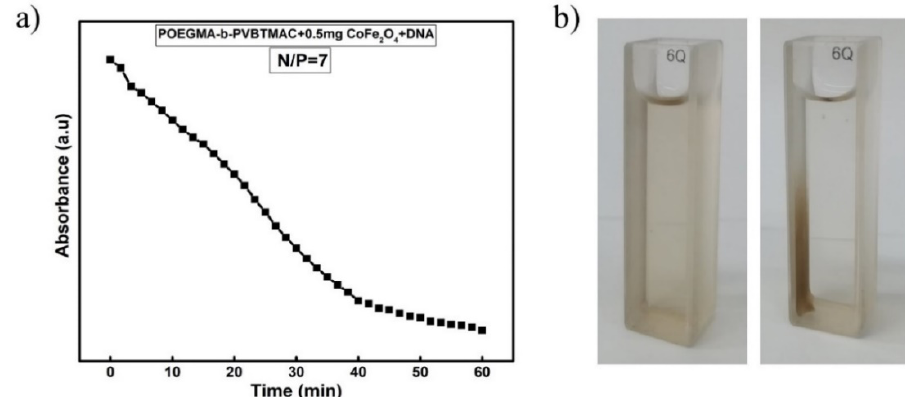
Figure 9. ( a ) Magnetophoresis plot showing absorbance as a function of time for magnetopolyplexes ( λ = 450 nm) at N / P = 7, ( b ) magnetopolyplexes before and after the application of magnetic field (using a magnet) for the magnetophoresis experiments.